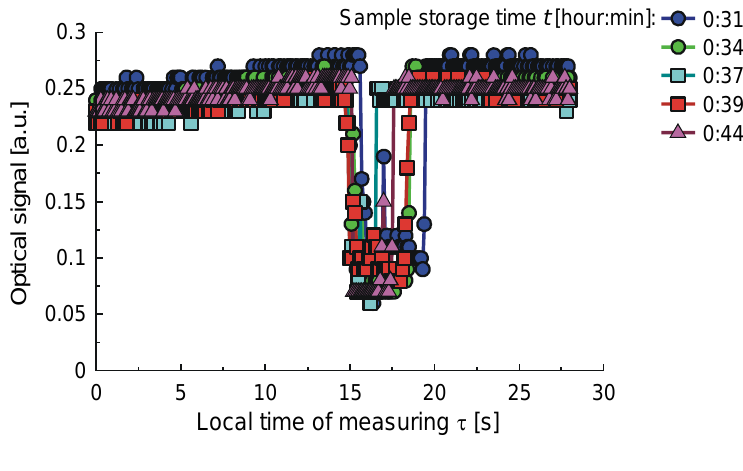
Figure 17. Signals from milk samples after storage of 31 to 44 minutes.